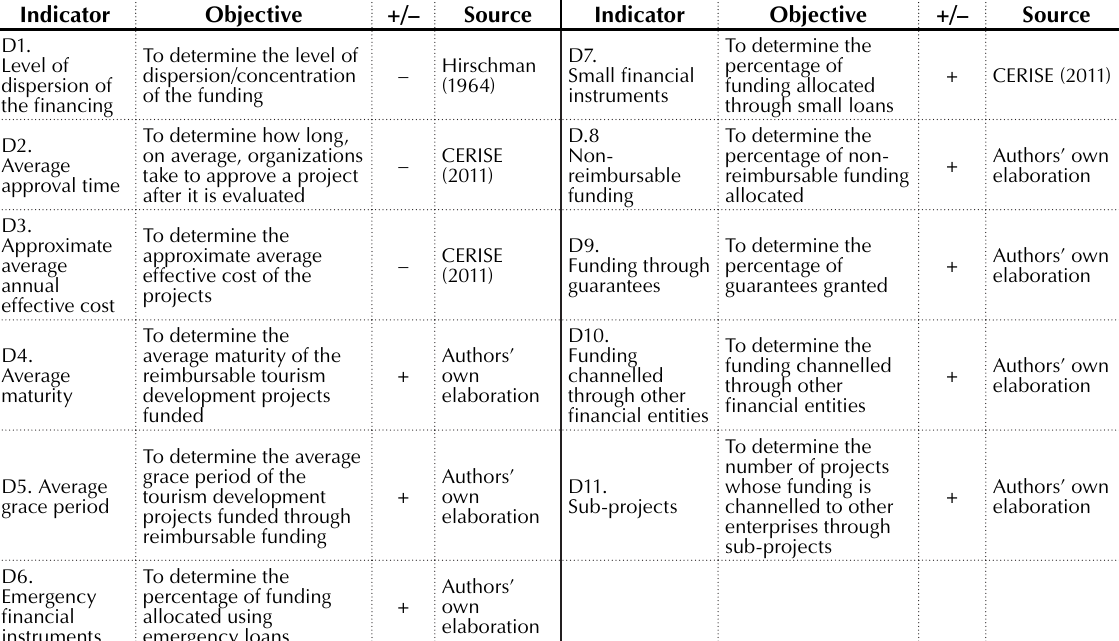
Source: Authors’ own